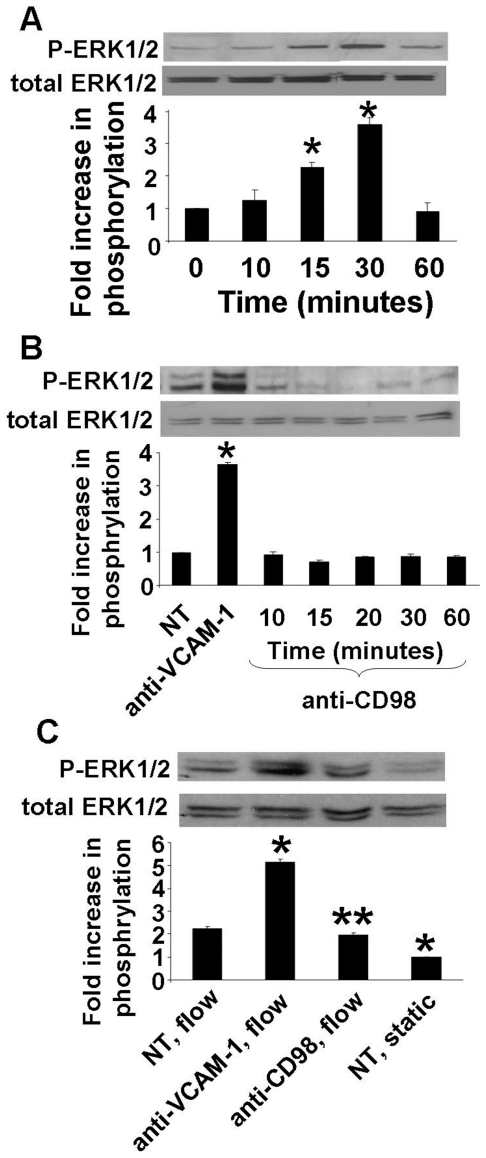
VCAM-1 induces an increase in phosphorylation of ERK1/2 in endothelial cell lines under static and laminar flow conditions.Confluent monolayers of mHEVa cells were stimulated with 27 µg/ml anti-VCAM-1 (or the binding control anti-CD98) plus 15 µg/ml of a secondary antibody. ERK1/2 Thr202/Tyr204 phosphorylation (P-ERK1/2) and total ERK1/2 was determined by western blot. A) Time course for anti-VCAM-1 activation of ERK1/2 Thr202/Tyr204 phosphorylation under static conditions. B) Stimulation of VCAM-1 for 30 minutes and time course for antibody crosslinking of the control CD98 under static conditions. C) Confluent monolayers of HEV were non-treated (NT) or stimulated with anti-VCAM-1 or the control anti-CD98 under 2 dynes/cm2 laminar flow or nontreated under static conditions for 15 minutes. *, p<0.05 compared to A) 0 minutes, B) NT and C) the NT,flow group. In panel C) **, p<0.5 compared to the anti-VCAM-1, flow group.